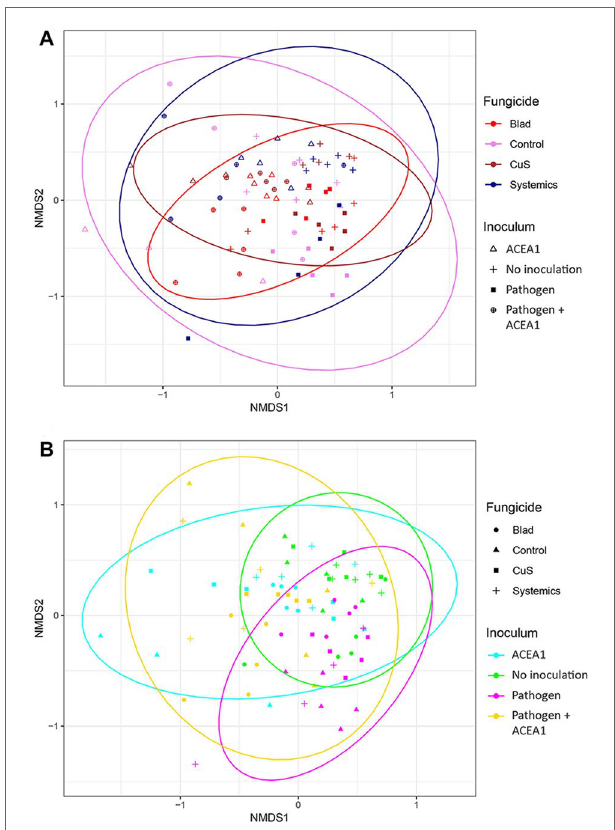
FIGURE 5 | Non-metric multidimensional scaling (NMDS) plots based on Jaccard’s index. Fungal communities present in grapevine cuttings added with water (No inoculation), Phaeomoniella chlamydospora (Pathogen), a consortium of fungal wood endophytes (ACEA1), or both P. chlamydospora and ACEA1. Inoculated plants were sprayed with either Blad or potassium permanganate (Control) or copper oxychloride and sulfur (CuS) or penconazole and fosetyl-aluminum (Systemics). n = 5 for each combination inoculum/treatment. Ellipses illustrate the multivariate normal distribution of samples within the same fungicide (A) or inoculum (B)